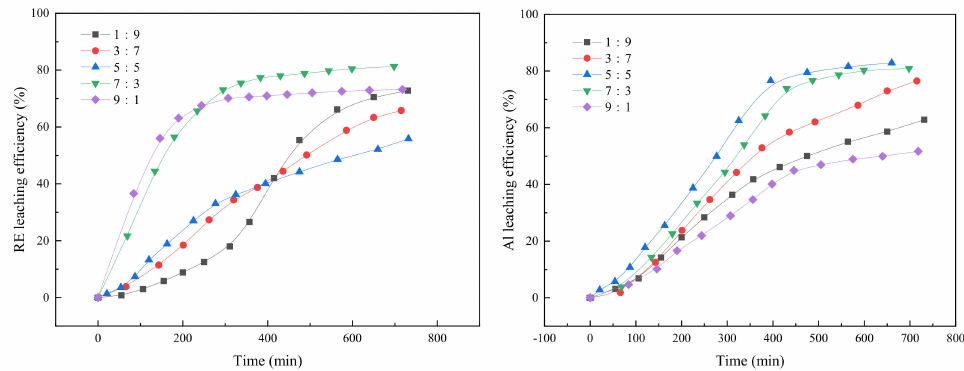
Figure 4. E ff ects of the molar ratio of leaching agent on the leaching processes of RE and